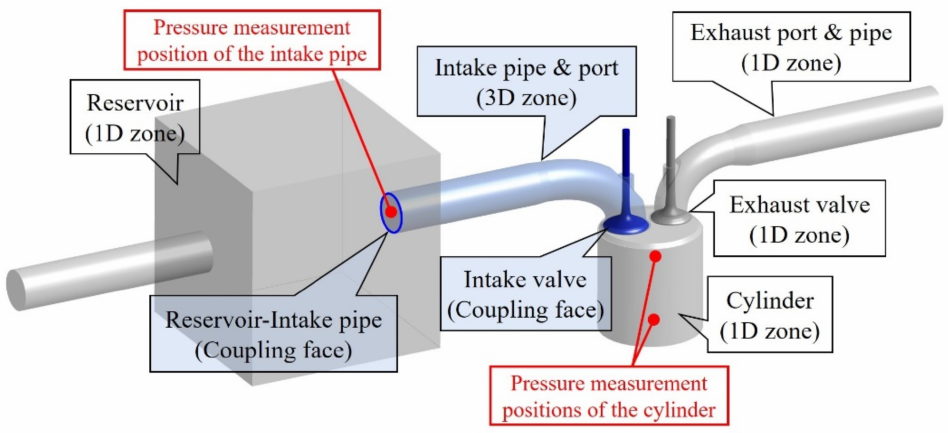
Figure 1. Schematic diagram of the compression ignition engine model for gas flow analysis and pressure measurement positions for validation.